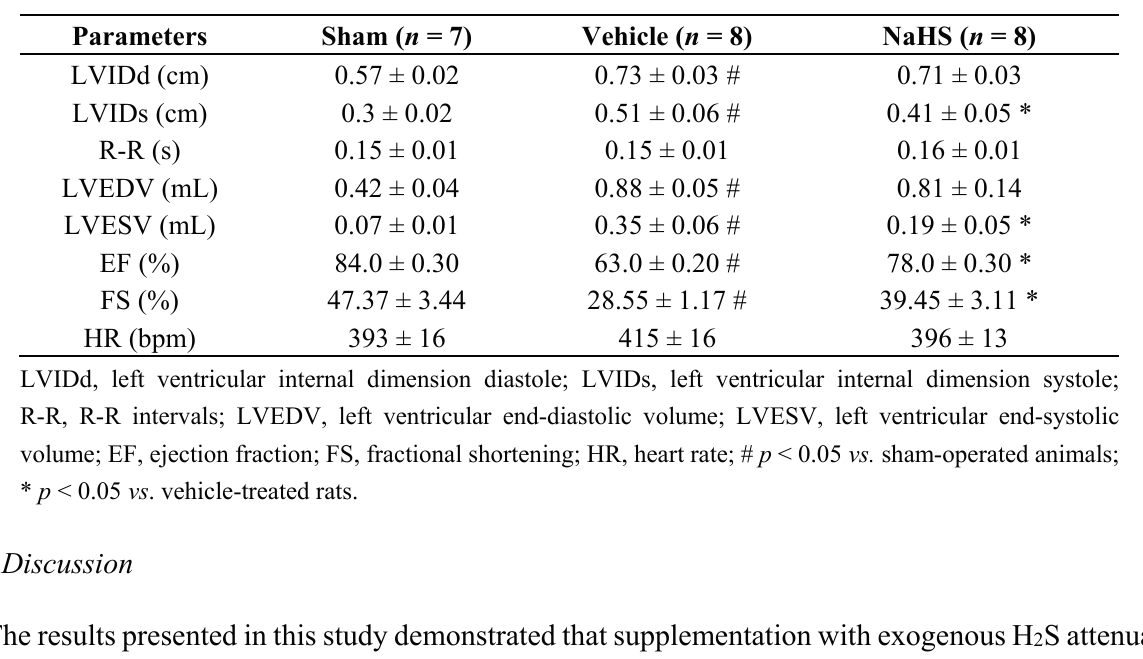
Table 1. Echocardiographic